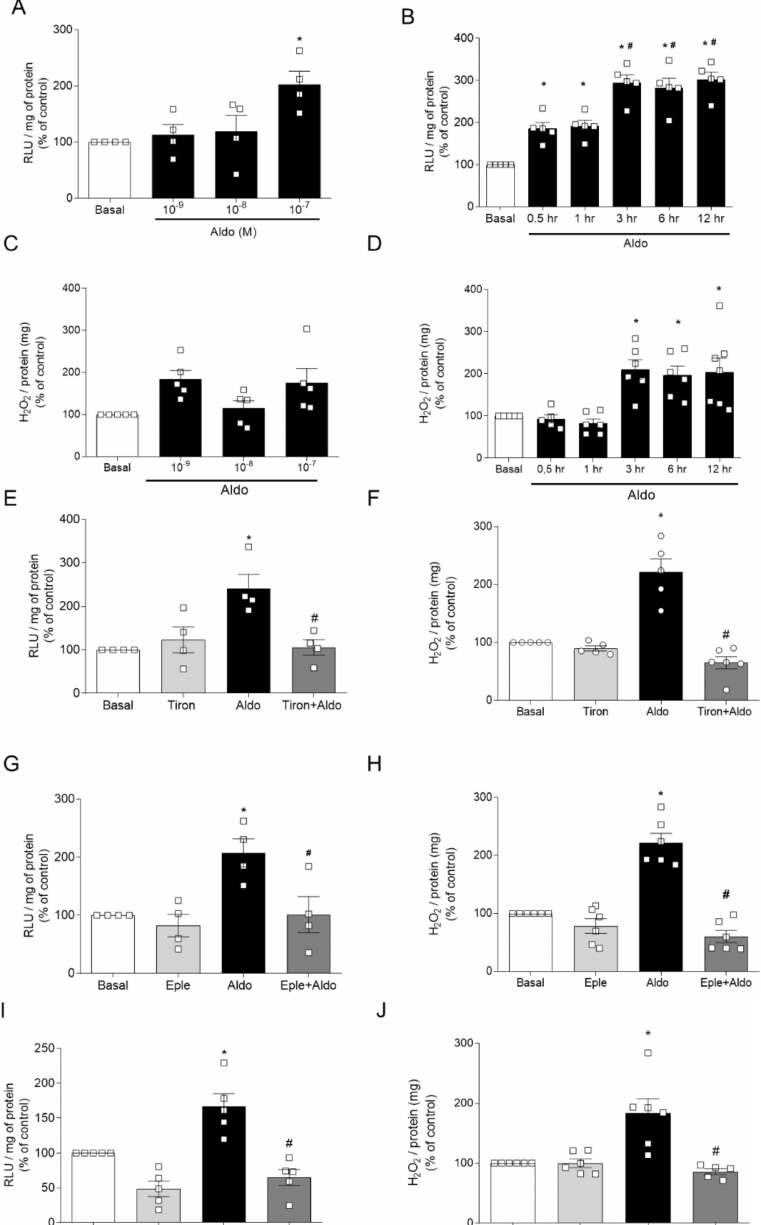
Figure 3. Aldosterone induces ROS generation in EA.hy926 cells. Superoxide anion ( A , B ) and hydrogen peroxide ( C , D ) generation in EA.hy926 cells treated with Aldo at various time points and concentrations. Superoxide anion ( E , G , I ) and hydrogen peroxide ( F , H , J ) generation in EA.hy926 cells treated with Aldo (100 nM for 30 min) in the presence of tiron (100 µ M for 30 min), Eple (1 µ M for 30 min), or SFN (1 µ M for 3 h). Data represent the mean ± SEM. One-way ANOVA: * p < 0.05 vs. basal; #, p < 0.05 vs. 0.5 h. n = 4–6 for each experimental group. Similar to Aldo’s effects on aortic rings, Aldo-induced ROS generation in EA.hy926 cells was prevented by an ROS scavenger, MR antagonist, and Nrf2 activator. Tiron (100 µ M, 30 min) blocked O 2 − and H 2 O 2 generation (Figure 3E,F). Eplerenone (1 µ M, 30 min), as well as pharmacological activation of Nrf2 with SFN (1 µ M for 3 h), prevented Aldo-induced ROS generation in endothelial cells (Figure 3G–J,